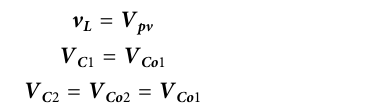
Table 2 is a comparison between previously published 7-level